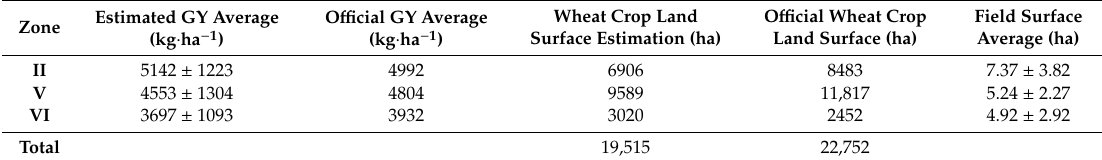
Figure 5. Crop type map output obtained from Sentinel-2 imagery and RF classification for the three segregated zones. The zoom-in shows the false color B3-B4-B8 image ( A ) and a closer classification output (parcels filtered) ( B ). UTM coordinates are expressed in meters. Table 9. Statistics for grain yield (GY), total wheat crop land surface studied, and farmer field average surface from both the o ffi cial regional Government of Navarre (www.navarra.es) and the calculated results for the season 2017–2018 at the regions Montaña (zone II), Media (zone V), and Ribera Alta (zone